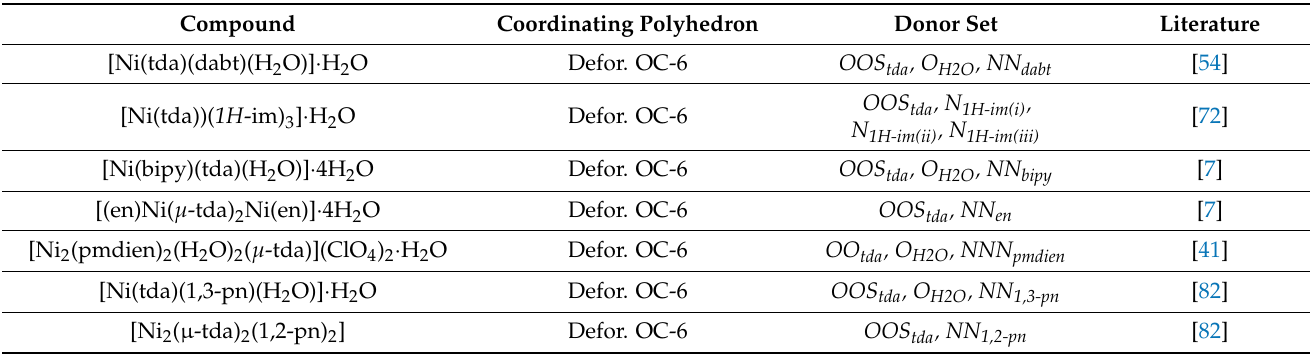
Table 8. Ni(II) complexes with 2,2 1 -thiodiacetic acid and N donor ligands that are structurally characterized.